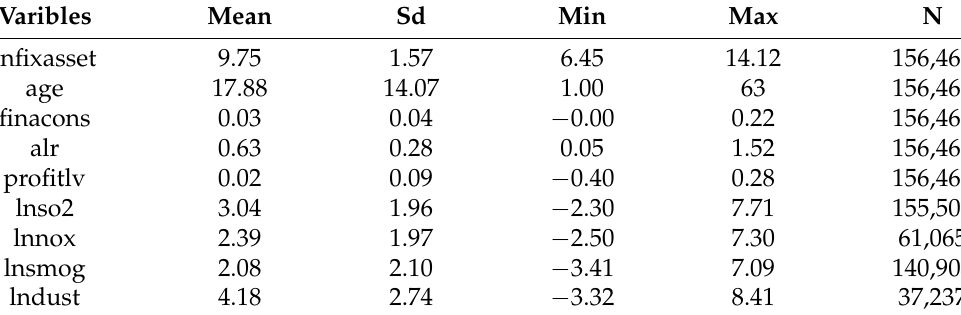
Table 1. Descriptive statistical